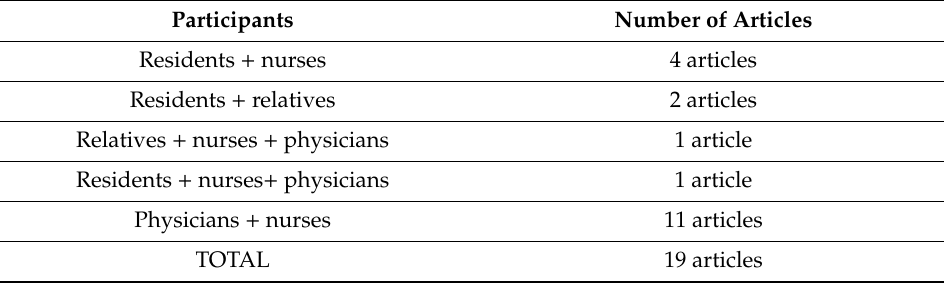
Table 2. Interventions targeting more than one category of